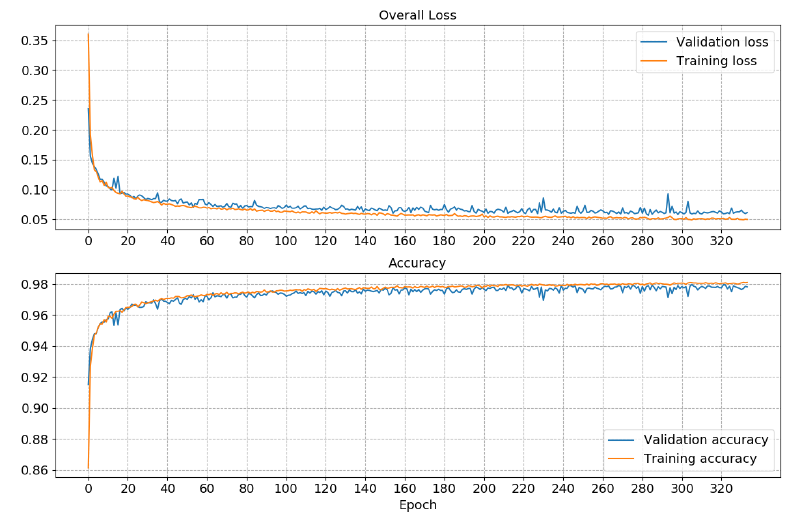
Figure 3. Convergence of the BCNN. In total it ran for 334 epochs, approximately two hours of train/validation time with a NVIDIA Titan V GPU.